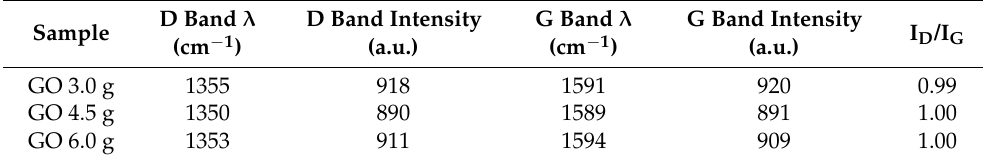
Table 2. Wavenumber ( λ ), D and G bands intensities and ID/IG ratios of GO